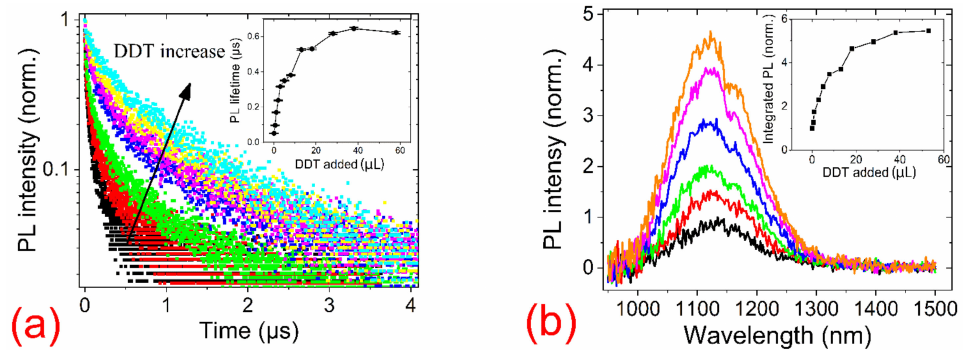
Figure 2. ( a ) PL decay curves for the 1:15 QD-rGO system with different amounts of added DDT. Inset—average PL lifetimes of the 1:15 QD-rGO system plotted vs. amount of added DDT; ( b ) PL spectra for the 1:15 QD-rGO system with different amounts of added DDT. Inset—integrated PL intensity vs. amount of added